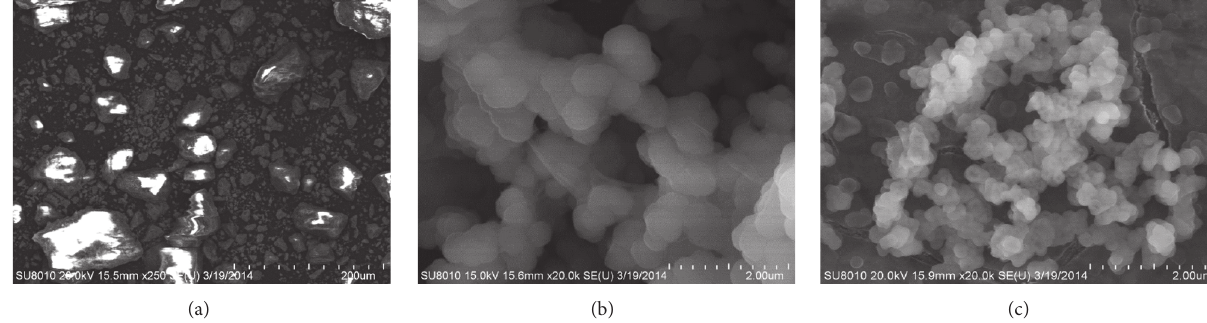
Figure 1: Morphologies of fish bone particles. (a) Micro fish bone powder, (b) micron fish bone particles in the emulsion with 1h of high- energy wet media milling, and (c) micron fish bone particles in emulsion with 6 h of